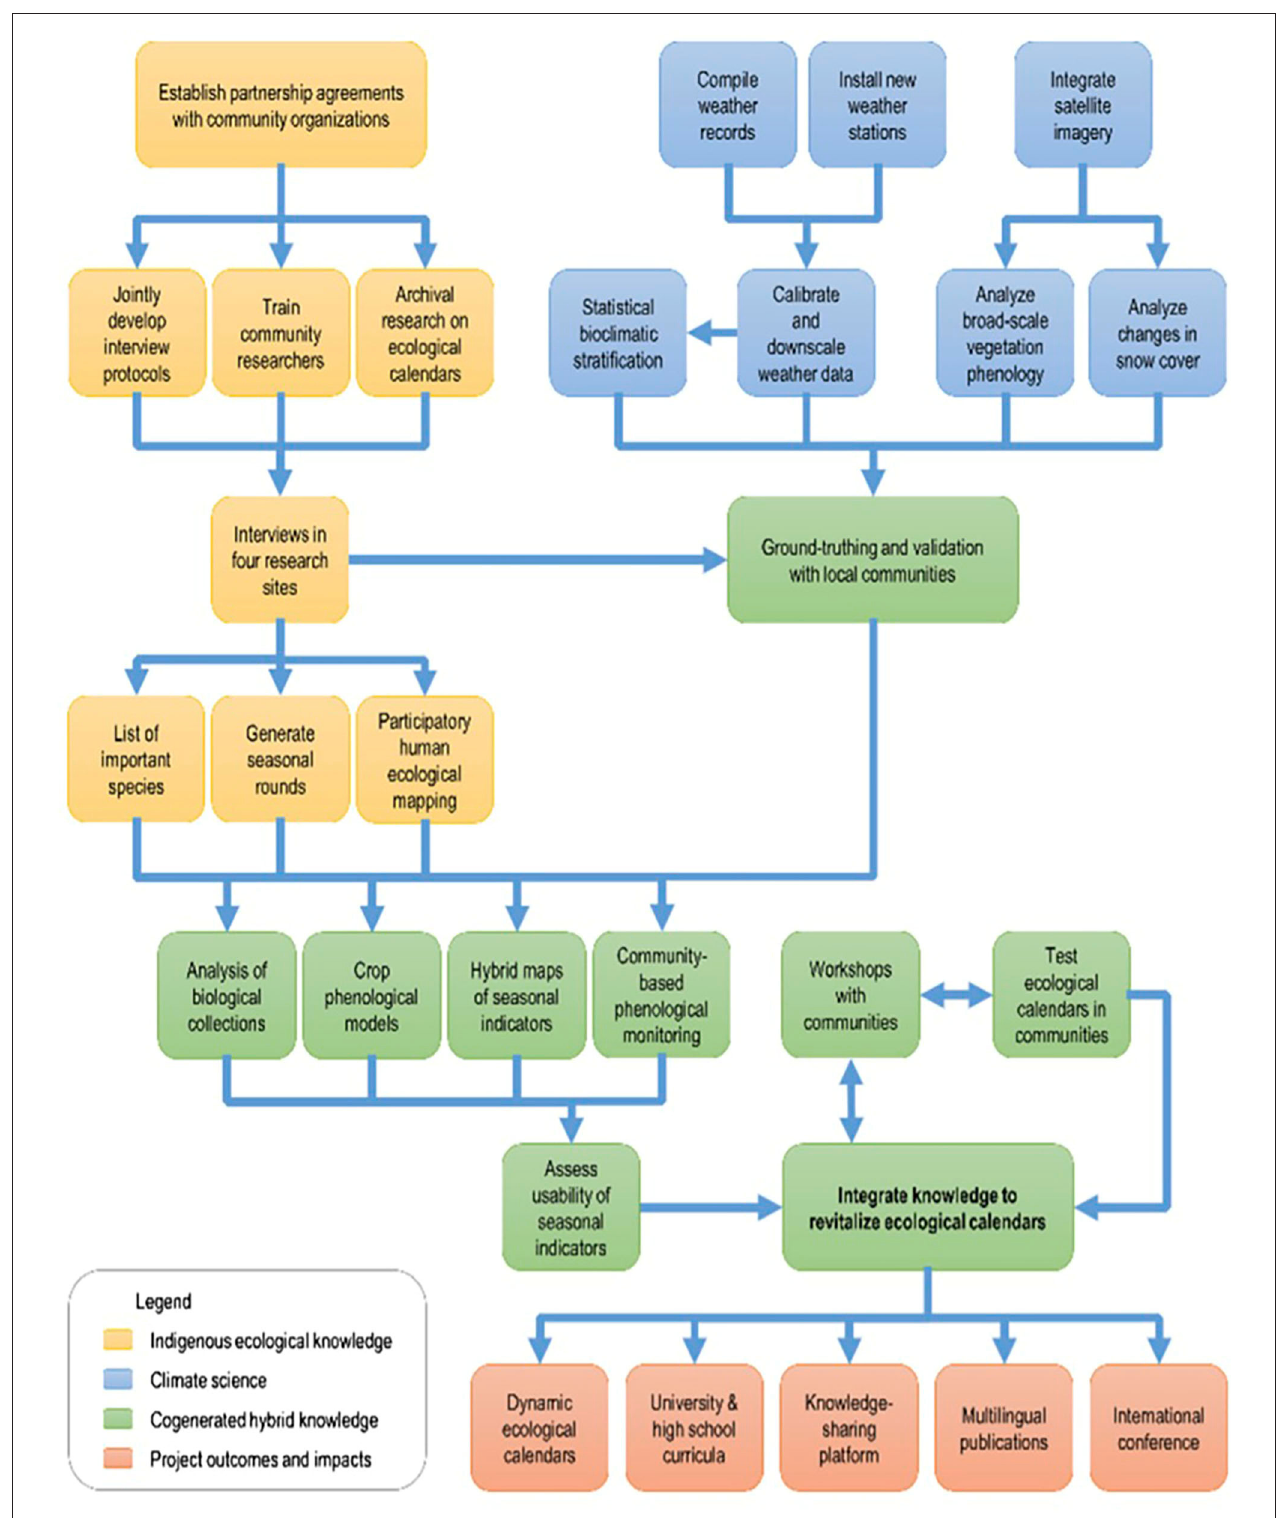
FIGURE 1 | Transdisciplinary research process and knowledge integration in the Pamir’s case, Afghanistan and Tajikistan [from Kassam et al. (2018)].